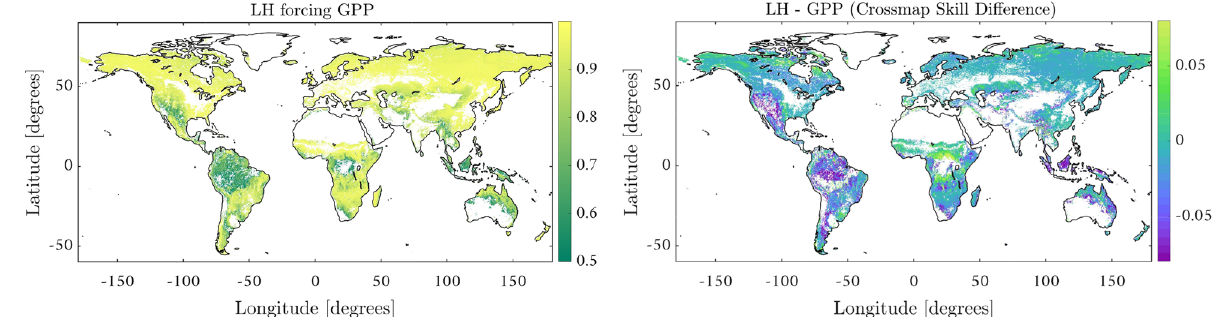
Figure 3. Results over two strongly coupled pair of variables (LH and GPP). Not only are the cross-map skills ( ρ ) really high in general (left figure), but also the link between these variables is further confirmed by the fact that both cross maps skills are almost identical as can seen by the low differences between them (right figure). The figure was generated using Matlab version R2018a (https:// es. mathw orks.